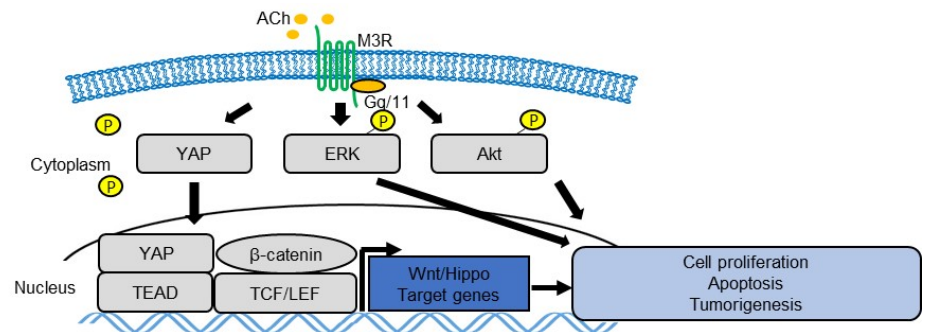
Figure 1. Schema of ACh-muscarinic acetylcholine receptor 3 (M3R) signaling pathway in gastrointestinal (GI) tumor cells. ACh-M3R signaling regulates cell proliferation, survival, and tumorigenesis by activating various signaling pathways, such as mitogen-activated protein kinase (MAPK), Akt, yes-associated protein (YAP), and Wnt.